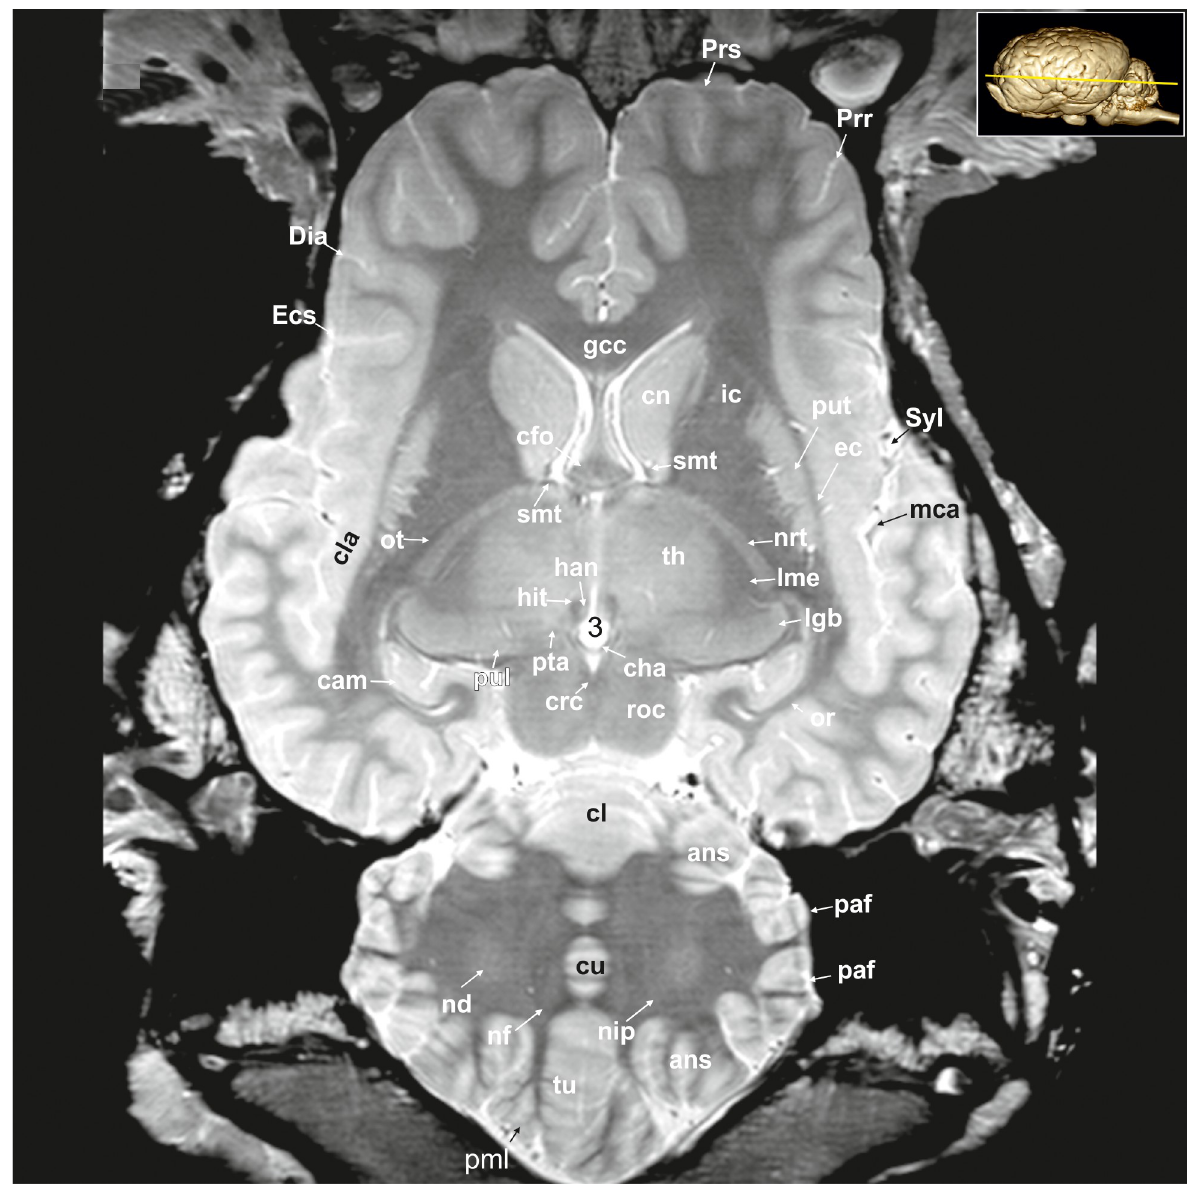
Fig 22. Dorsal magnetic resonance image of the equine brain on the level of the rostral colliculi. ans: ansiform lobule, cam: ammon’s horn, cfo: corpus of fornix, cha: habenular commissure, cl: central lobule, cla: claustrum, cn: caudate nucleus, crc: cerebral crus, cu: culmen, Dia: diagonal sulcus, ec: external capsule, Ecs: ectosylvian sulcus, gcc: genu of the corpus callosum, han: habenular nuclei, hit: habenulo-interpeduncular tract, ic: internal capsule, lgb: lateral geniculate body, lme: external medullary lamina, mca: medial cerebral artery, nd: dentate nucleus, nf: fastigial nucleus, nip: interpositus nucleus, nrt: reticular nucleus of the thalamus, or: optic radiation, ot: optic tract, paf: paraflocculus, pml: paramedian lobule, Prr: prorean sulcus, Prs: presylvian sulcus, pta: pretectal area, pul: pulvinar nuclei, put: putamen, roc: rostral colliculus, smt: stria medullaris thalami, Syl: sylvian fissure, th: thalamus, tu: tuber of the vermis, 3: third ventricle.